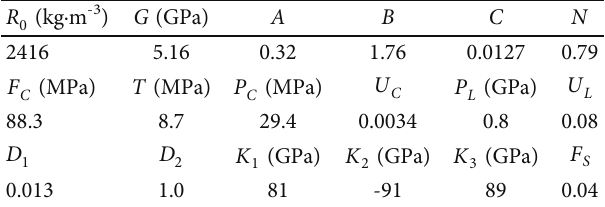
Table 3: Gray sandstone HJC model parameters.